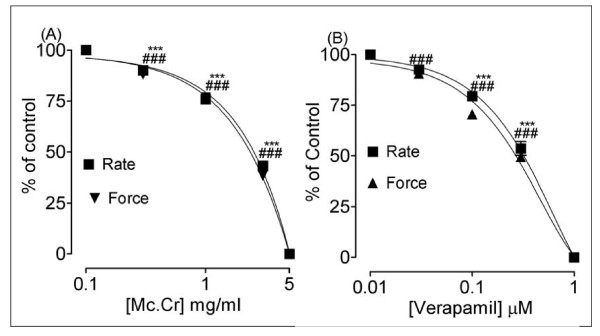
Inhibitory effect of (A) Mc.Cr and (B) verapamil on the force and rate of spontaneous contractions of isolated guinea-pig atria. #P < 0.05; ##P < 0.01; ###P < 0.001; show comparison of concentration-dependent effects on force while *P < 0.05;**P < 0.01; ***P < 0.001; show comparison of concentration-dependent effects on rate of guinea-pig atria.